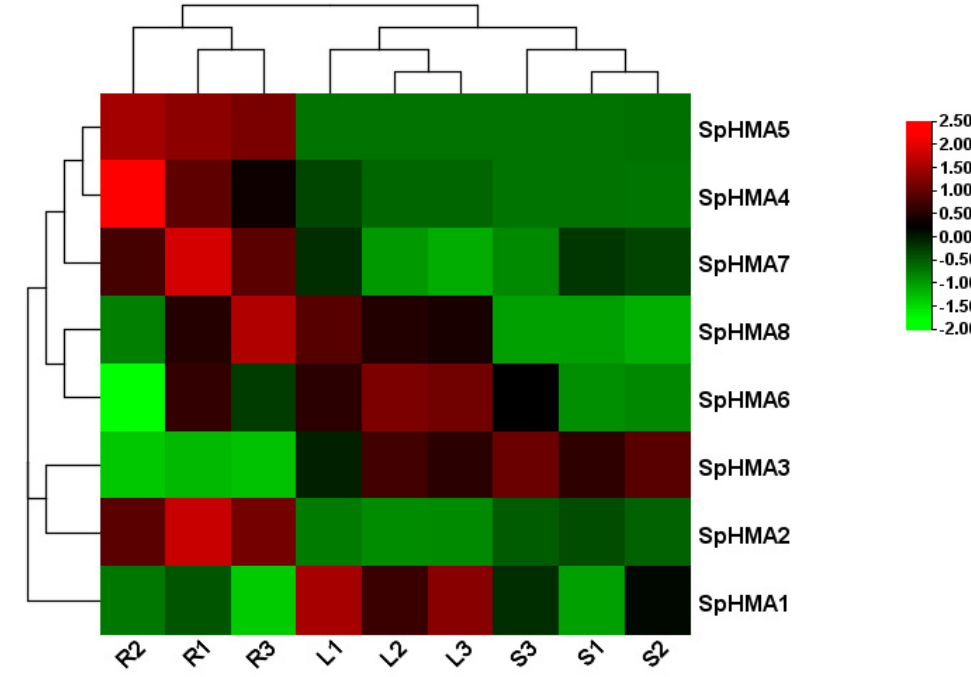
Figure 6. Expression pattern of 8 SpHMA genes in different tissues (R: roots; L: leaves; S: stems; 1, 2, and 3 are three biological replicates). The heat map was drawn using log2 transformed values, red and green represent high and low expression levels, respectively.